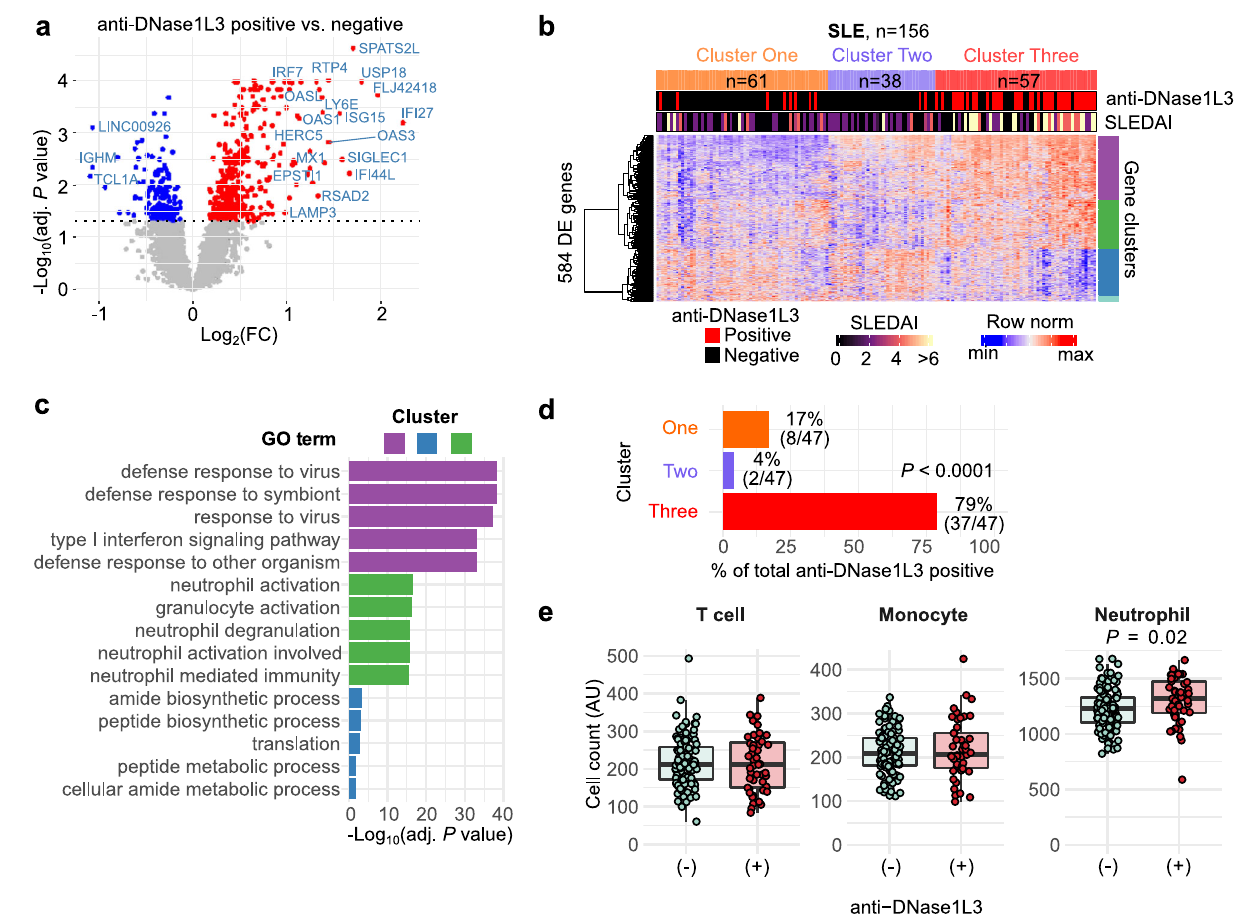
Fig.2|Transcriptionalcorrelatesofanti-DNase1L3antibodiesinSLE.a Volcano plot of 584 differentially expressed transcripts (DETs) between SLE patients posi- tive and negative for anti-DNase1L3 antibodies. Red, 399 upregulated DETs with adjusted P <0.01. Blue, 185 downregulated DETs with adjusted P <0.01. DETs with P value<0.01 and Log2(Fold change) >1 are marked ( b ). Hierarchical clustering of 584 DETs from a . Each column represents an individual patient and each row an individual gene. Top annotations show cluster membership, anti-DNase1L3 anti- bodies (positive = red, negative = black), and SLEDAI score in continuous scale. DETsweresplitin k =4expressionclustersandannotatedbyfunctionalenrichment analysis using the g: Pro fi ler toolset with the gene oncology molecular function (GO:MF) gene set collection. Red represents upregulated genes and blue